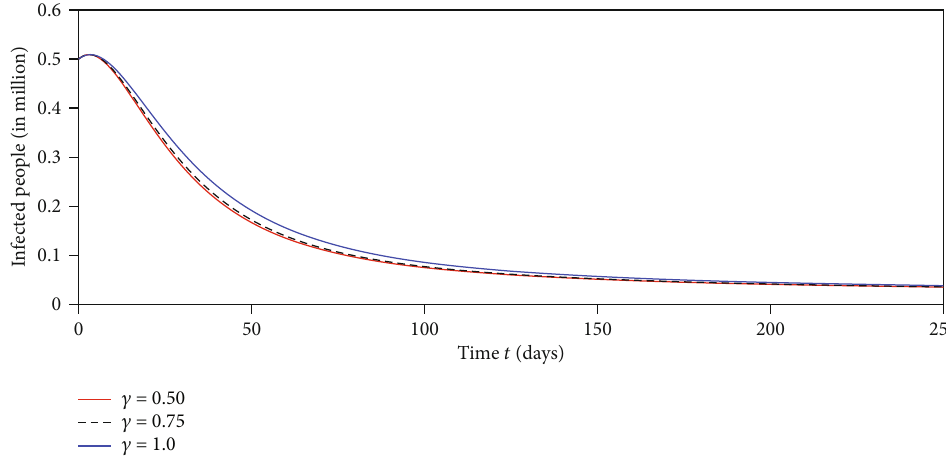
Figure 2: Graphical representation of the approximate solution of an infected class at three di ff erent fractionals.